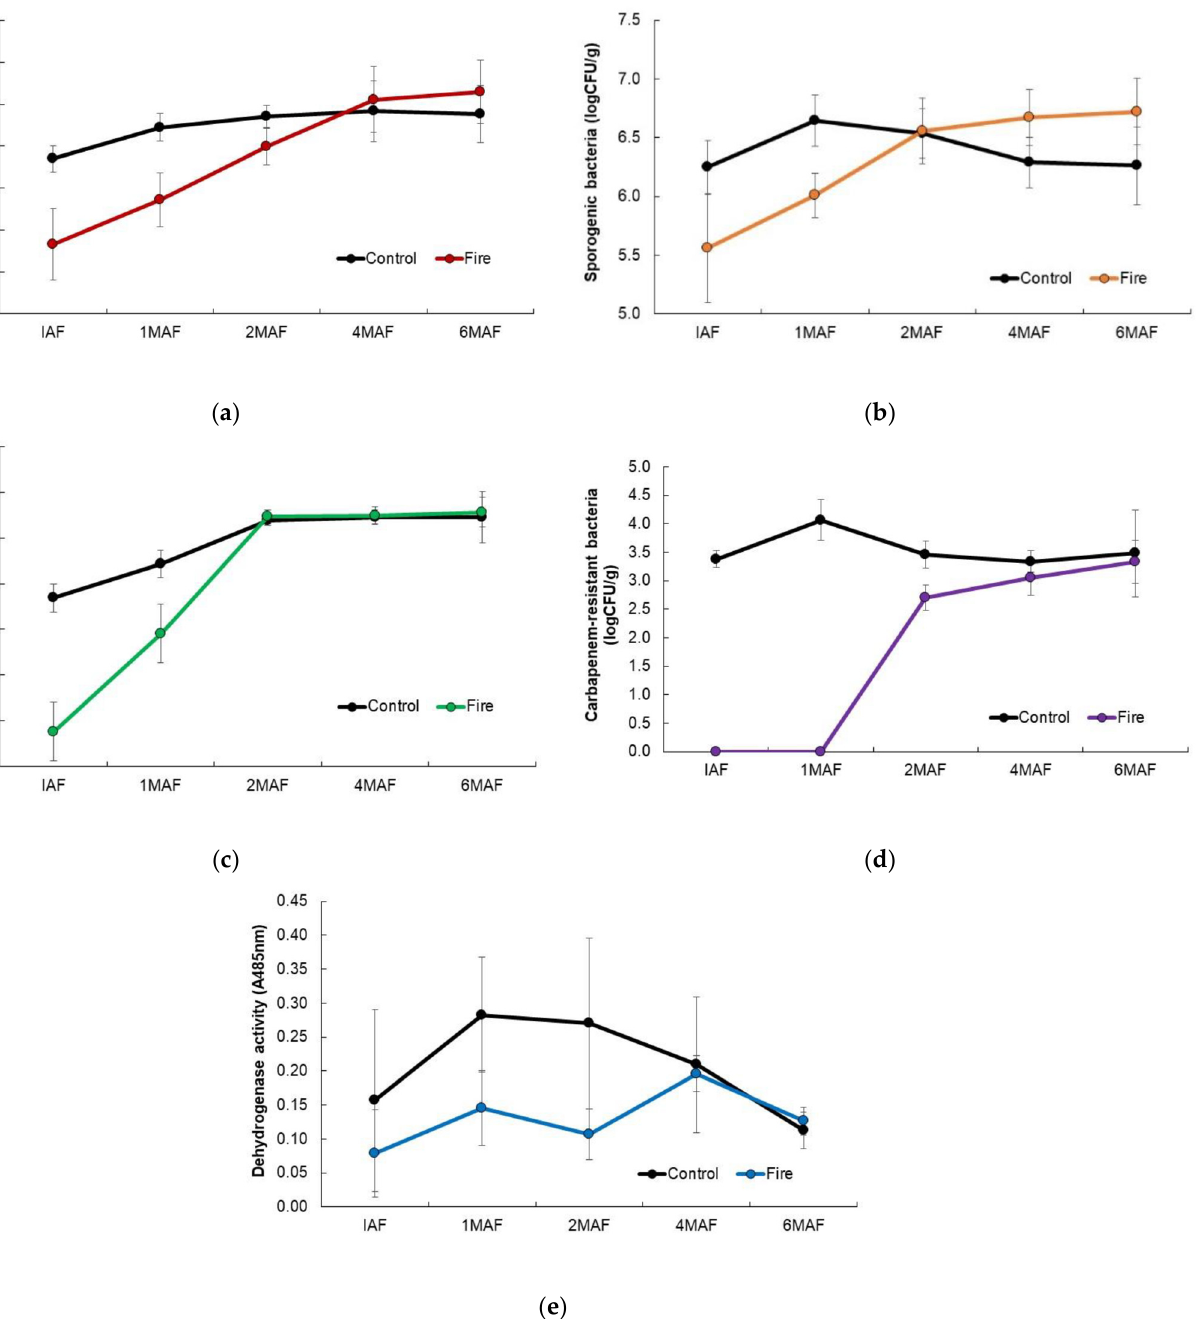
Figure A1. Numbers of ( a ) total heterotrophic bacteria, ( b ) sporogenic bacteria, ( c ) phosphate- solubilising bacteria, ( d ) carbapenem-resistant bacteria, and ( e ) dehydrogenase activity (mean values and standard deviations) in the control and fi re treatments during the study period (IAF, immediately after fi re; MAF, months after fi re).